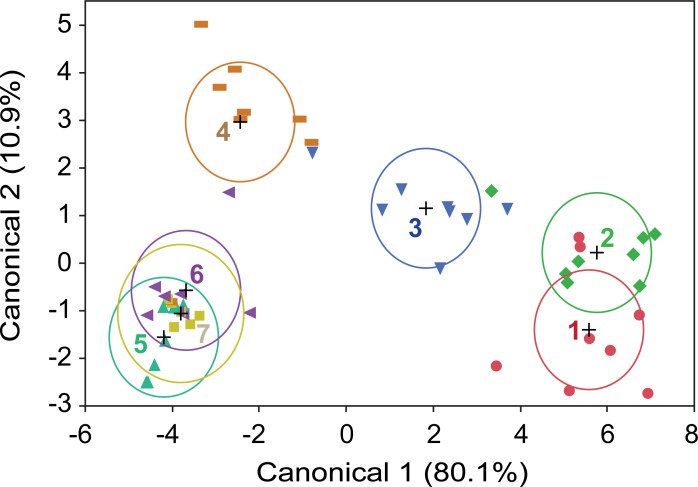
Linear discriminant analysis of 8 neonate pigs over 7 days of decomposition.The percentage representation of dipteran and coleopteran taxa (8 Diptera, 10 Coleoptera) trapped or hand-collected daily was used in the analysis. Color-coded numbers represent day of decomposition of each replicate pig. The plus (+) corresponds to each age group mean, and ellipses represent 95% confidence intervals for each mean.